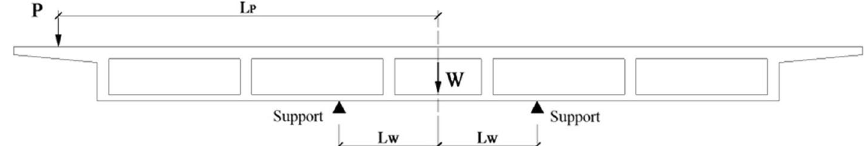
Fig. 17 The diagram of Algorithm